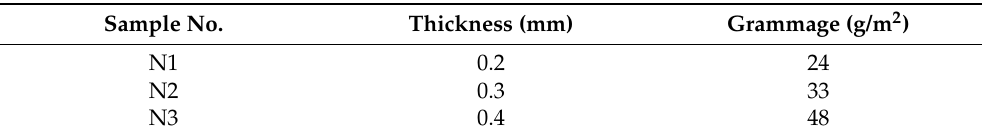
Table 1. Parameters of melt-blown nonwoven fabrics.